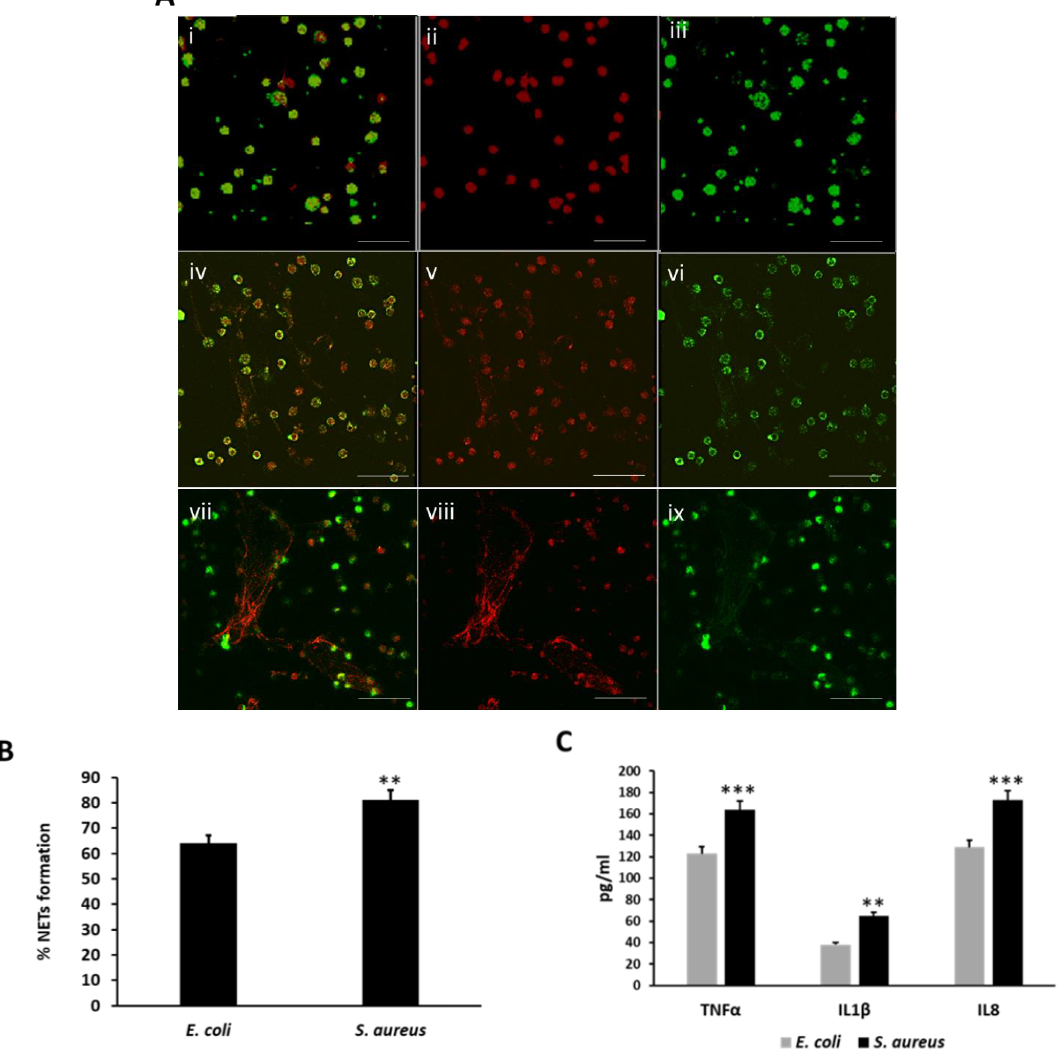
Figure 3. ( A ) Confocal images showing the formation of NETs in control (top panel), E. coli (middle panel), and S. aureus (bottom panel) spiked neutrophils. i, iv, and vii are merged images of neutro- phils stained with SYTOX green and elastase antibody conjugated with Alexa flour 647. ii, v, and viii are the images of neutrophils stained with elastase antibody conjugated with Alexa flour 647. iii, vi, and ix are the images of neutrophils stained with SYTOX green. The scale represents 50 μm. The images are representatives of three independent experiments. ( B ) Bar diagrams representing percent incidence of NETs release measured in neutrophils spiked with E. coli and S. aureus (** p < 0.01). ( C ) Bar diagrams representing the level of cytokines (TNF- α, IL - 1β, IL -8) in the culture super- natant of neutrophils spiked with E. coli and S. aureus (*** p < 0.001). 3.4. Estimation of Organ Dysfunction The level of organ dysfunction parameters and organ-specific dysfunction markers were evaluated and compared in the GPB and GNB group of patients. We found a higher level of SOFA (8.2 ± 1.7 versus 6.1 ± 1.4) (Figure 4A) and APACHE II score (21.2 ± 3.7 versus 19.1 ± 2.9) (Figure 4B) in the GPB group in comparison with the GNB group. The total bilirubin, which assesses the hepatotoxicity, was slightly higher in the GPB group compared with the GNB group (31.2 ± 5.7µmol/L versus 28.1 ± 4.4µmol/L) (Figure 4C). The creatinine level, a potent marker of kidney function, was found to be higher in the GPB group compared with the GNB group (198.5 ± 5.3µmol/Lversus185.2 ± 6.1µmol/L) (Figure 4D). The PaO 2 /FIO 2 ratio, which measures the lung function, was lower in the GPB group compared with the GNB group (216.4 ± 24.2µmol/L versus 296.5 ± 22.1 µmol/L) (Figure 4D).